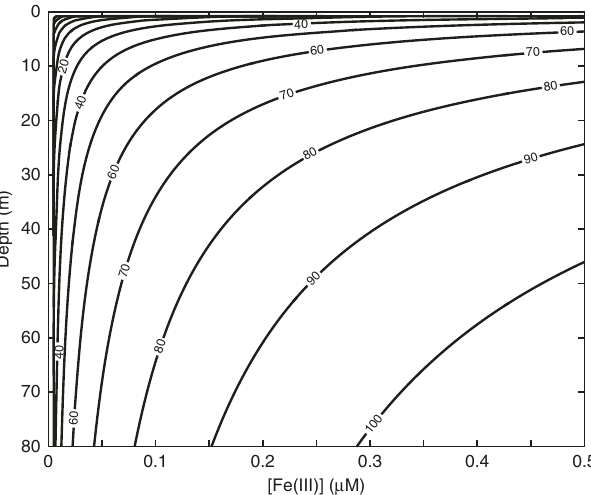
Fig. 6 Reaction transport model of predicted UV-C radiation absorbance with water column depth and Fe(III) concentration. Model parameters are based on experimental UV-C radiation (254 nm) attenuation data (% UV-C absorbed) in cell-free A + media solutions, and assume iron redox dynamics similar to those in modern Archean analog site Lake Matano (Sulawesi, Indonesia) 28